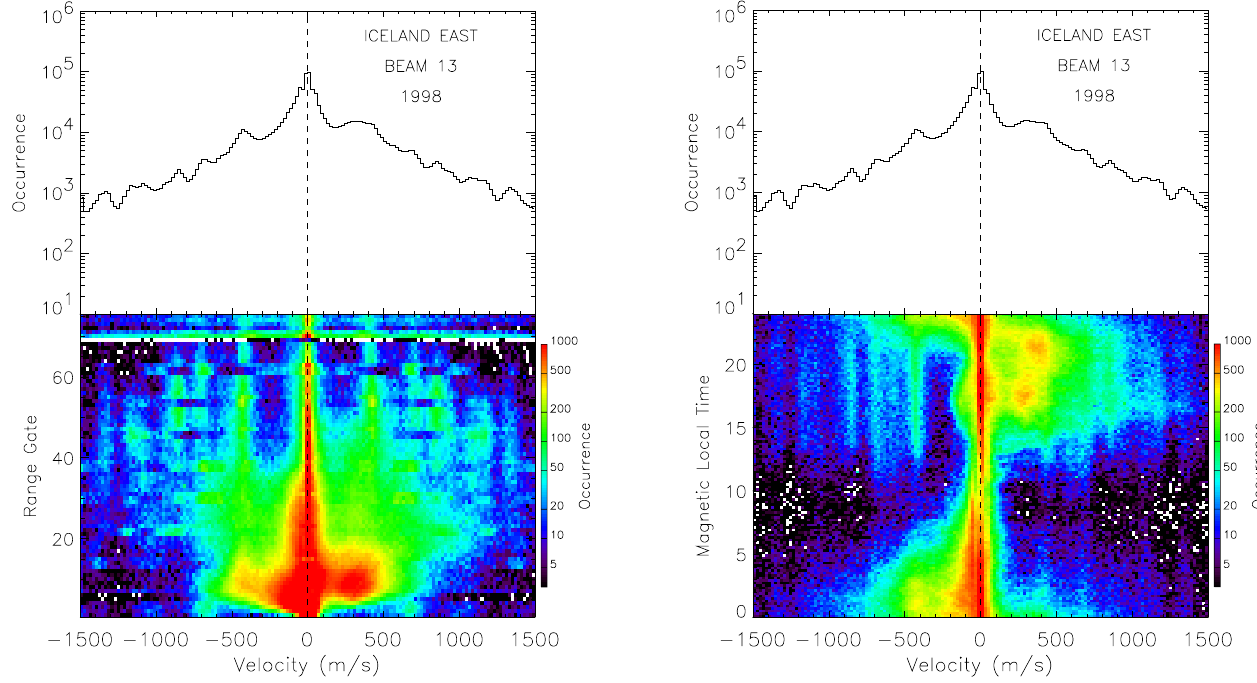
Fig. 3. Line-of-sight velocity distributions from Iceland East beam 13 for the whole of 1998. Additionally shown are (a) the distribution in range gate-velocity space, and (b) the distribution in magnetic local time-velocity space. Positive line-of-sight velocities represent the flow toward the radar, whereas negative line-of-sight velocities represent the flow away from the